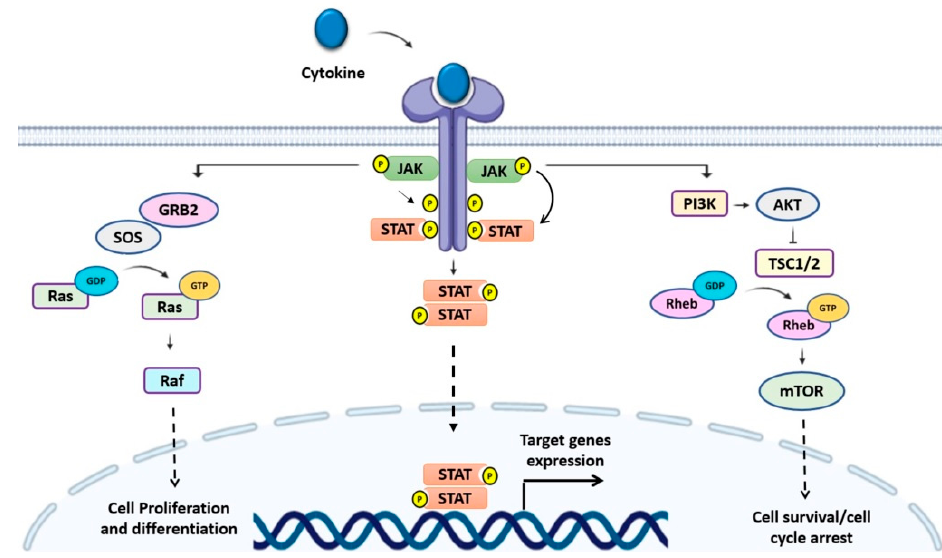
Figure 1. Schematic illustration of the Janus kinase signal transducer and activator of transcription (JAK/STAT) signaling cascade. The activation of JAKs subsequent cytokine binding results in the phosphorylation of STATs, which dissociate from the receptor, followed by dimerization and translocation to the nucleus to induce the transcription of the target genes. In addition to STATs, JAKs interact with various adaptor proteins, triggering several signaling cascades such as mitogen-activated protein kinase (MAPK), phosphatidylinositol-3-kinase (PI3K), a serine/threonine- protein kinase (AKT), and mammalian target of rapamycin (mTOR), which ultimately regulate cell proliferation, differentiation, cell survival, and cell cycle